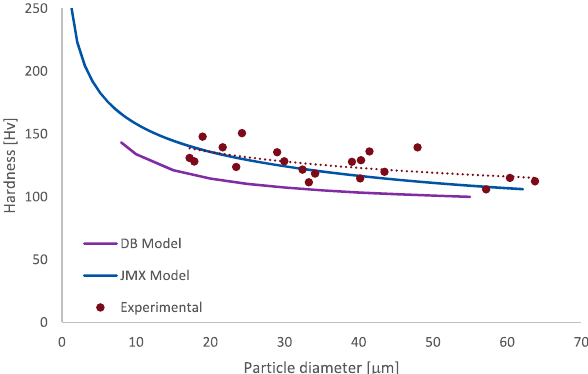
Figure 21. Hardness as a function of powder particle diameter associated with an earlier version of the additive yield strength model and the JMatPro mechanical property model, identified in the legend of the graph as “JMX,” hardness model compared to experimentally measured nanoindentation and microscopy informed data.